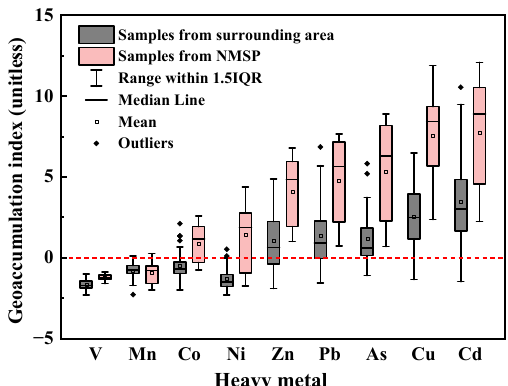
Figure 1. Geoaccumulation index (I geo ) values for heavy metals in soils of surrounding area and non-ferrous metal smelting plant (NMSP).